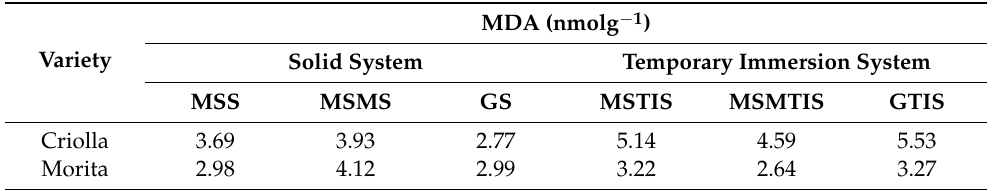
Table 2. Comparison of average MDA values obtained in the micropropagation of stevia varieties in the substrates